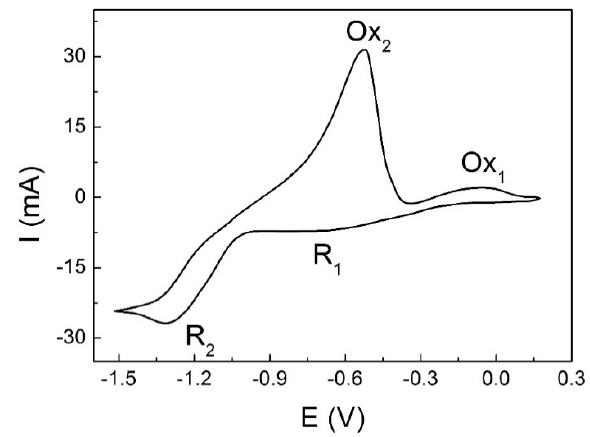
Figure 3. Cyclic voltammetric curve obtained in the NaCl–KCl–NaF–K 2 NbF 7 melt. ν = 0.1 V·s − 1 , t = 750 ° С , C K ₂ NbF ₇ = 5.05 × 10 − 4 mol·cm − 3 .